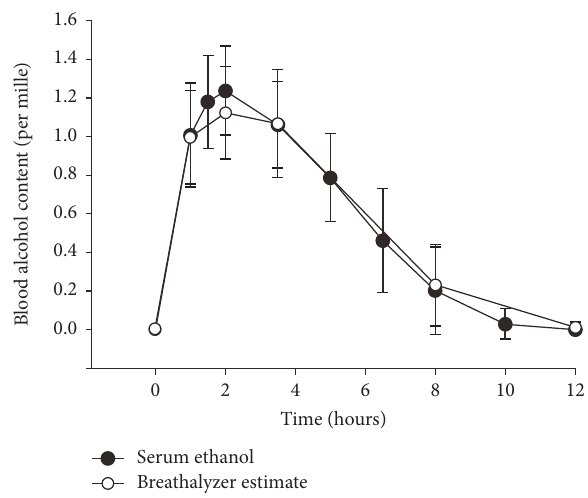
Figure 1: Elimination curve of ethanol following binge drinking of vodka amounting 4.28 mL/kg body weight as assessed by blood ethanol content and breathalyzer